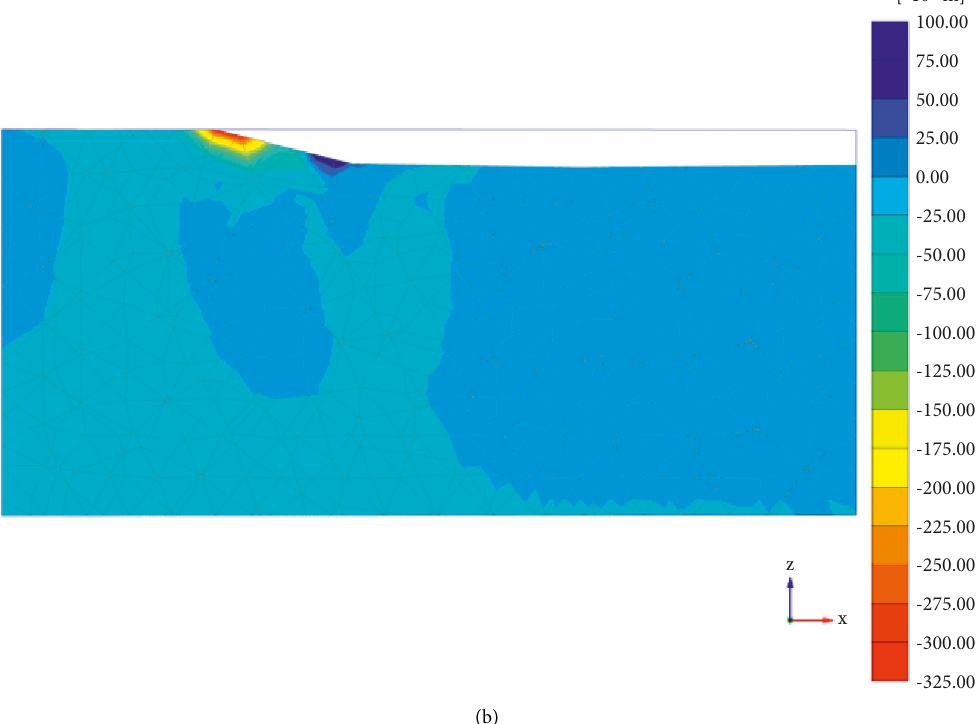
Figure 14: Deformation nephogram with or without grid. (a) No grid displacement cloud image. (b) Grid deformation cloud